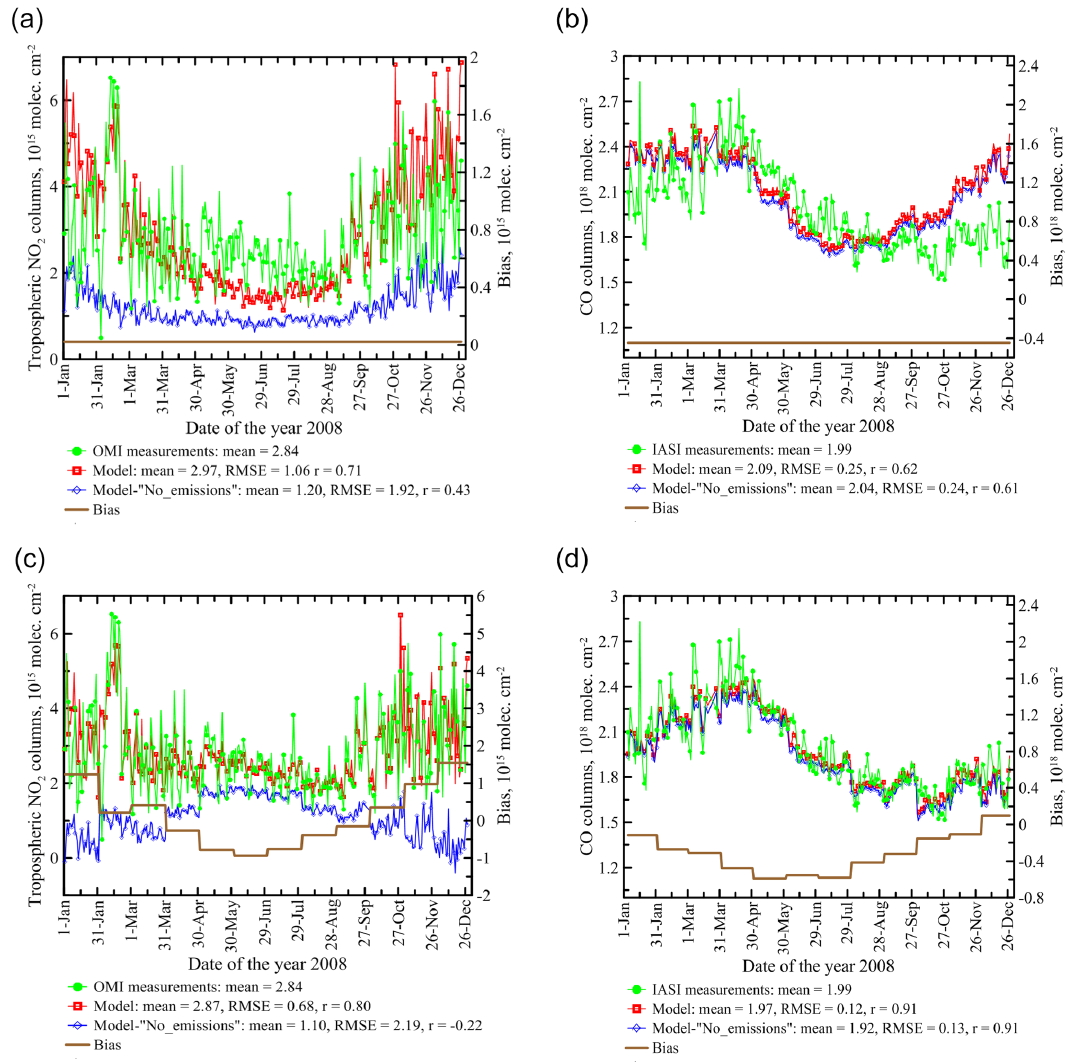
Figure 3. Time series of the spatially averaged NO 2 (a, c) and CO (b, d) columns retrieved from satellite measurements (see green curves) and simulated using the CHIMERE CTM both with and without anthropogenic emissions in the study region (see red and blue curves, respectively). The simulated data shown have been debiased: the differences (see brown curves) between either the annual (a, b) or monthly (c, d) averages of the simulation and measurement data were subtracted from the original simulation